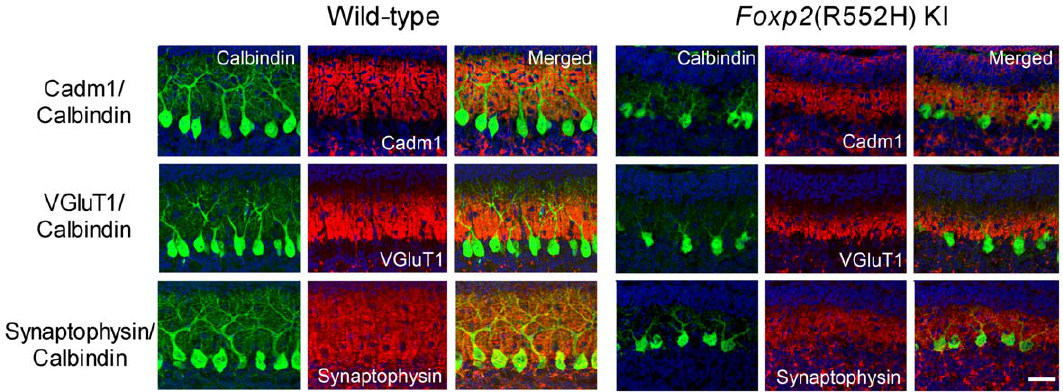
Figure 6. Altered distribution of Cadm1 in the molecular layer of wild-type and Foxp2 (R552H) KI mice (P11). Cadm1 preferentially distributed in the apical–distal dendritic portion in the molecular layer. The immunoreactivity of Cadm1 as well as that of Synaptophysin and VGluT1, pre-synaptic markers, was decreased in the molecular layer of the Foxp2 (R552H) KI mice. Green, Calbindin. Red, Cadm1, VGluT1, Synaptophysin. Blue, Hoechst. Bar, 30 m m. Figure S1 Alteration of Purkinje cells in cerebellum of wild-type and Foxp2 (R552H) knock-in ( Foxp2 KI) mice, wild-type, and Cadm1 knockout ( Cadm1 KO) (P11). The immunoreactivity was performed using mouse anti-Calbindin. Bar, 20 m m. (TIF) Figure S2 Altered distribution of the Cadm1 of wild- type and Foxp2 (R552H) KI mice (P11). Values are mean 6